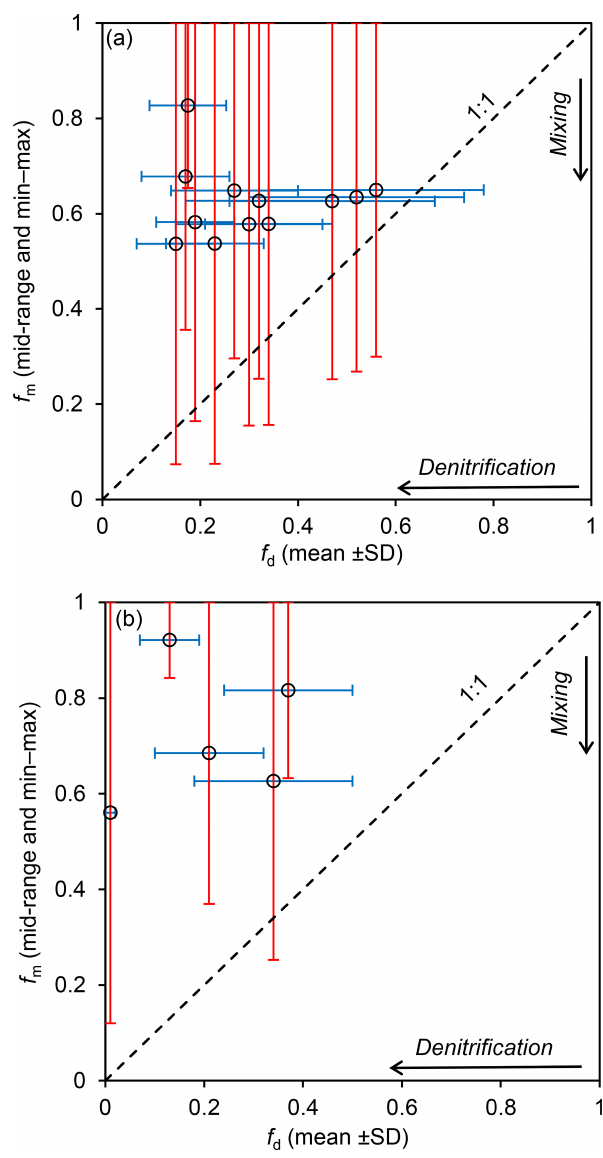
Figure 7. Relative contributions to NO − attenuation by mixing and 3 denitrification, as indicated by estimated f m and f d at (a) CFO1 and (b) CFO4, for groundwater samples with denitrification indicated by stable isotope values of NO − 3